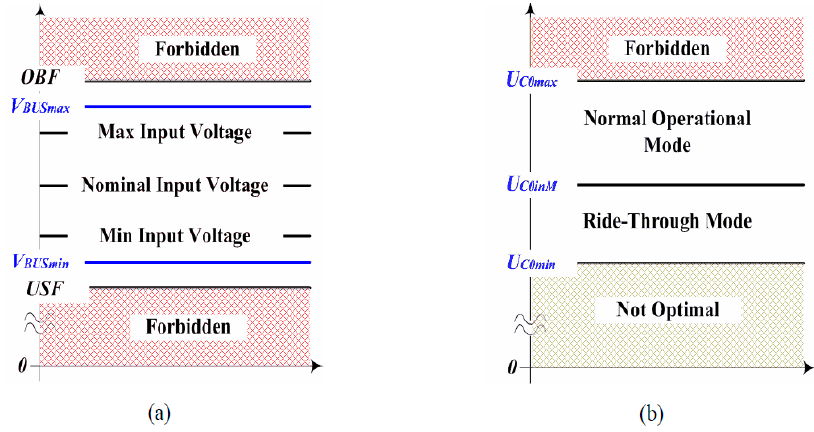
Figure 9. The boundary and limitation for the DC link voltage (a) and UC bank (b) [38].